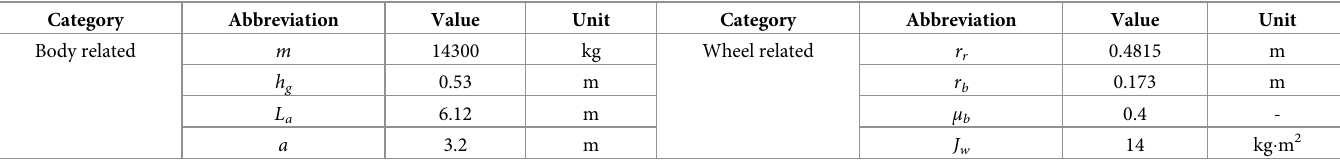
Table 2. The relevant parameters of the vehicle.